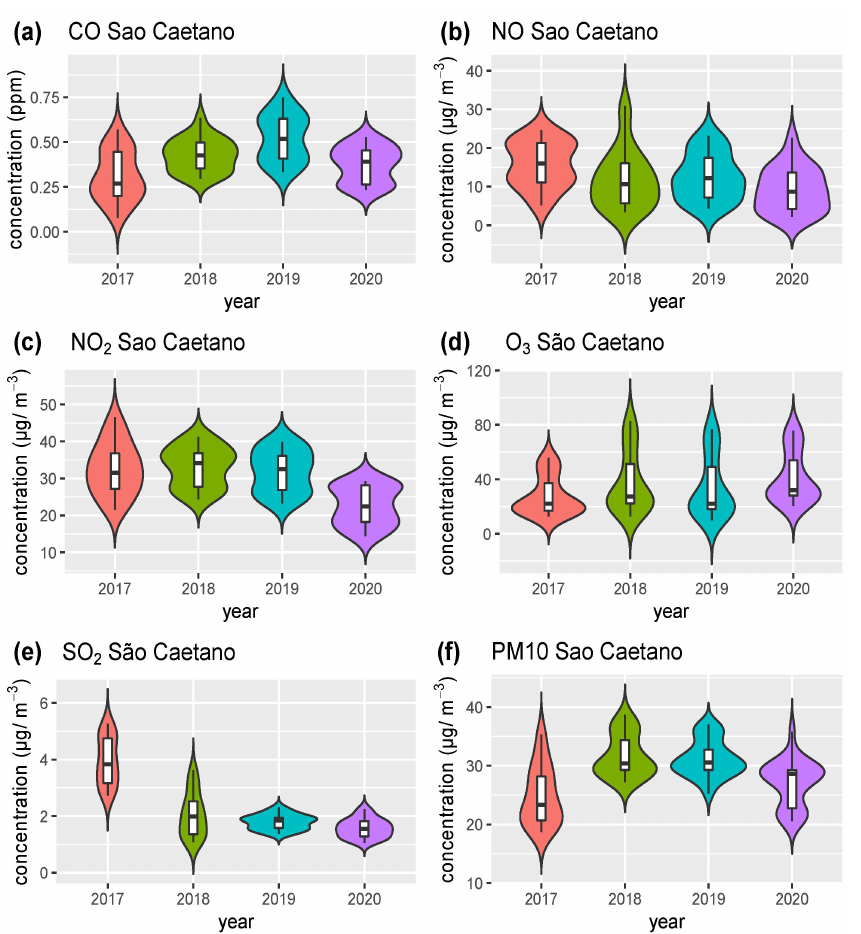
Figure 17. Violin graphs for S ã o Caetano do Sul station during April to May of 2017 to 2020 from ground